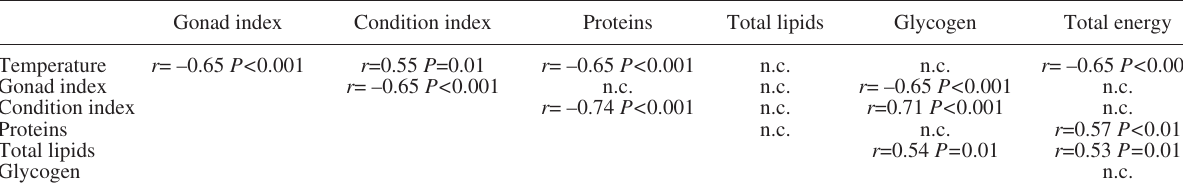
Fig . 3. – Monthly variations in gonadal development of V. senegalensis during 2006 and 2007. Males (top) and Females Table 1. – Results of Spearman correlation between studied parameters ( r , correlation coefficient, P , P value, n.c., no correlation was found)